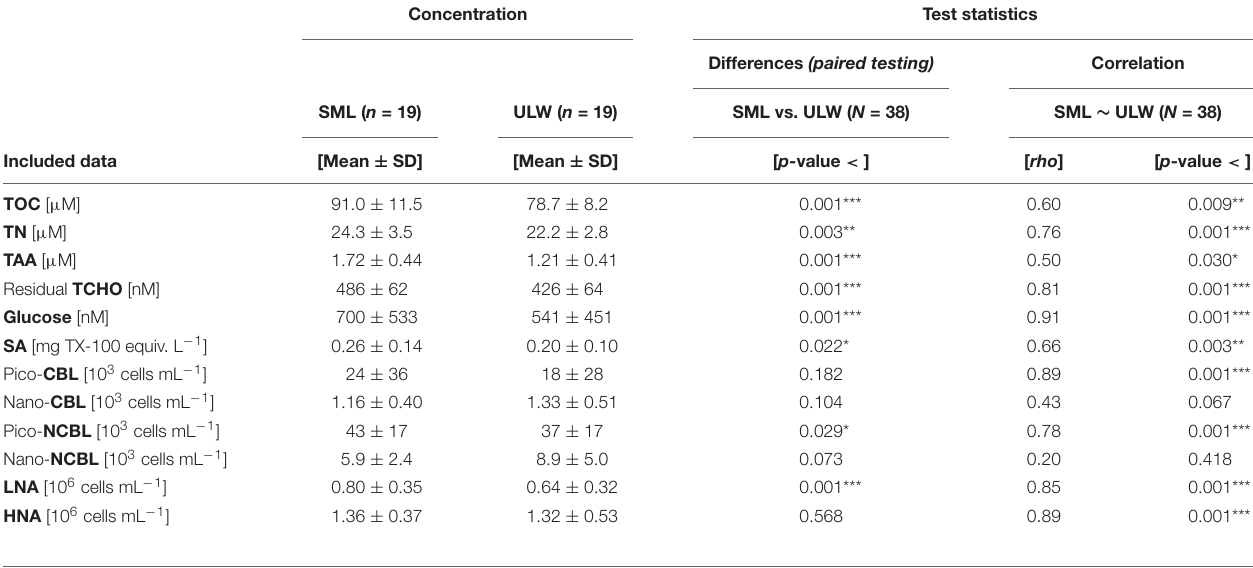
TABLE 2 | SML and ULW mean concentrations, standard deviations, and comparative statistics.